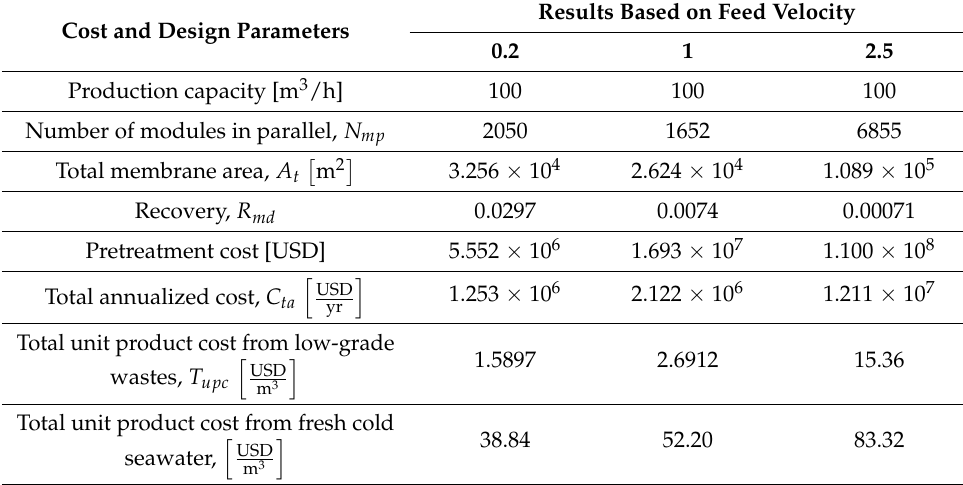
Table 7. MD design and cost results for the homemade